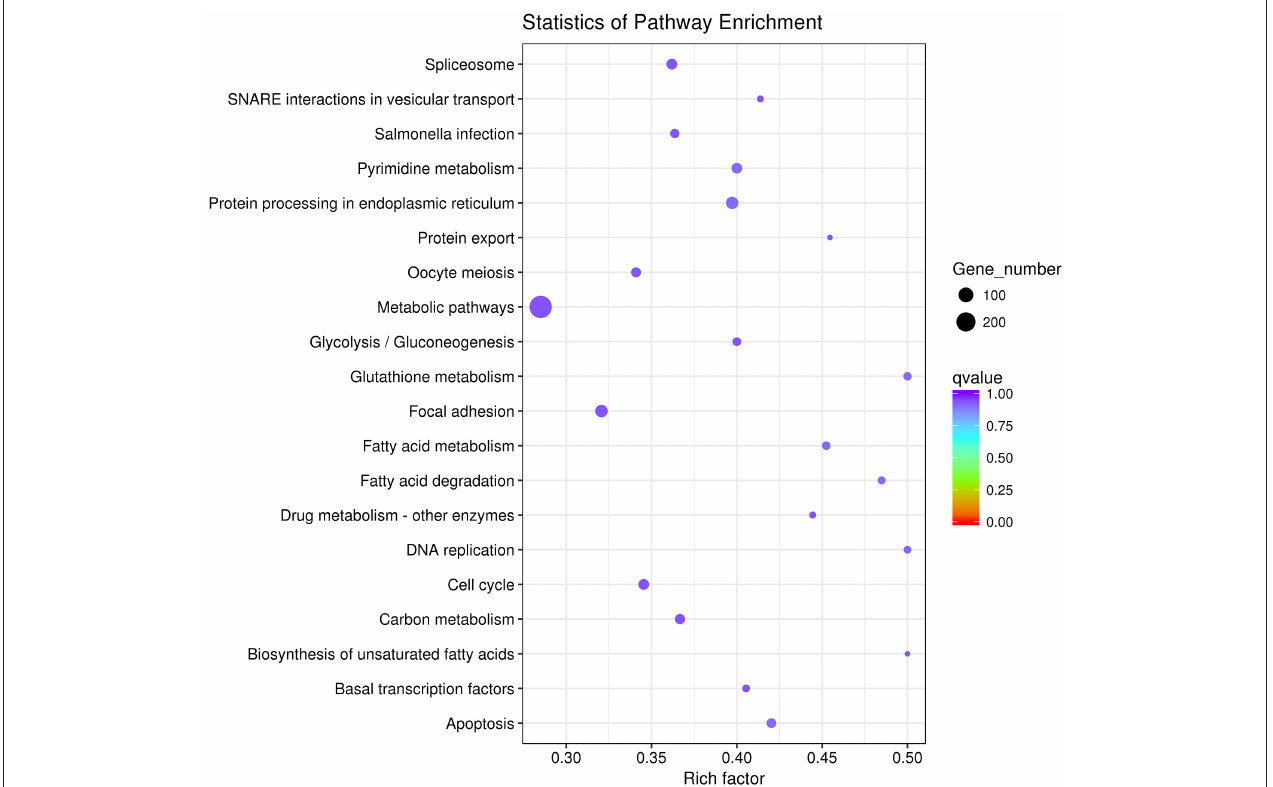
FIGURE 9 | The top 20 enriched KEGG pathways of the differentially expressed target genes of miRNAs.